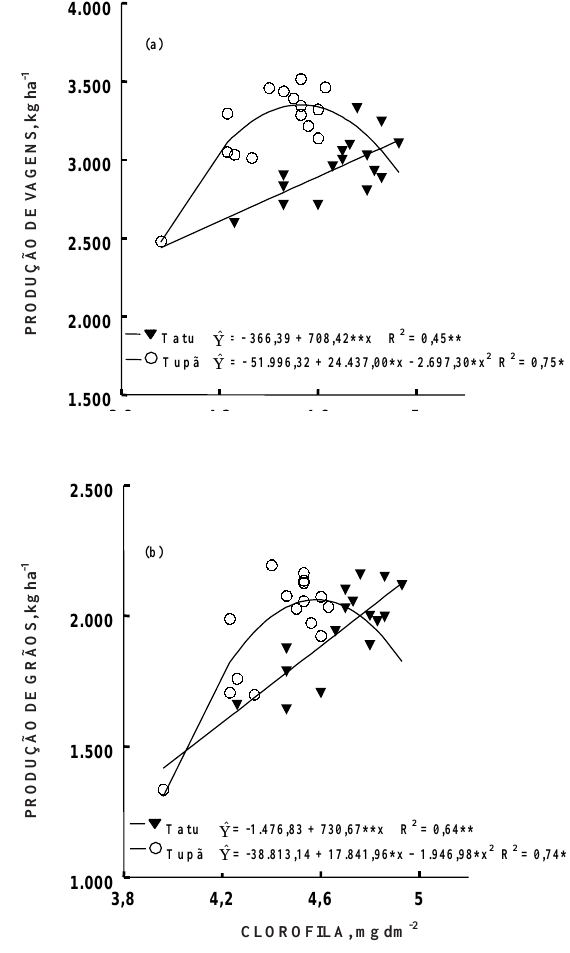
Figura 2. Relações entre a produção de vagens(a) e de grãos(b) e a concentração de clorofila nas folhas dos cultivares de amendoim no segundo cultivo, 1991/92. ** Significativo a 1% * Significativo a